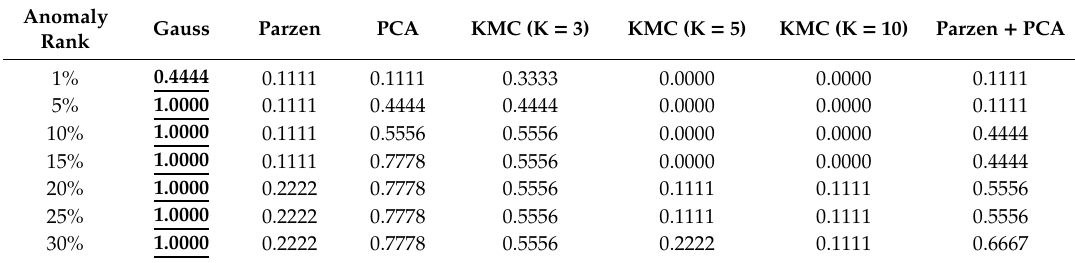
Table 16. True detection rate of each anomaly detection algorithm based on the e-mail communication network dataset (CDE1846). Best performance is shown in bold and underlined (number of normal behaviors in the test set: 456, number of malicious behaviors in the test set: 9).